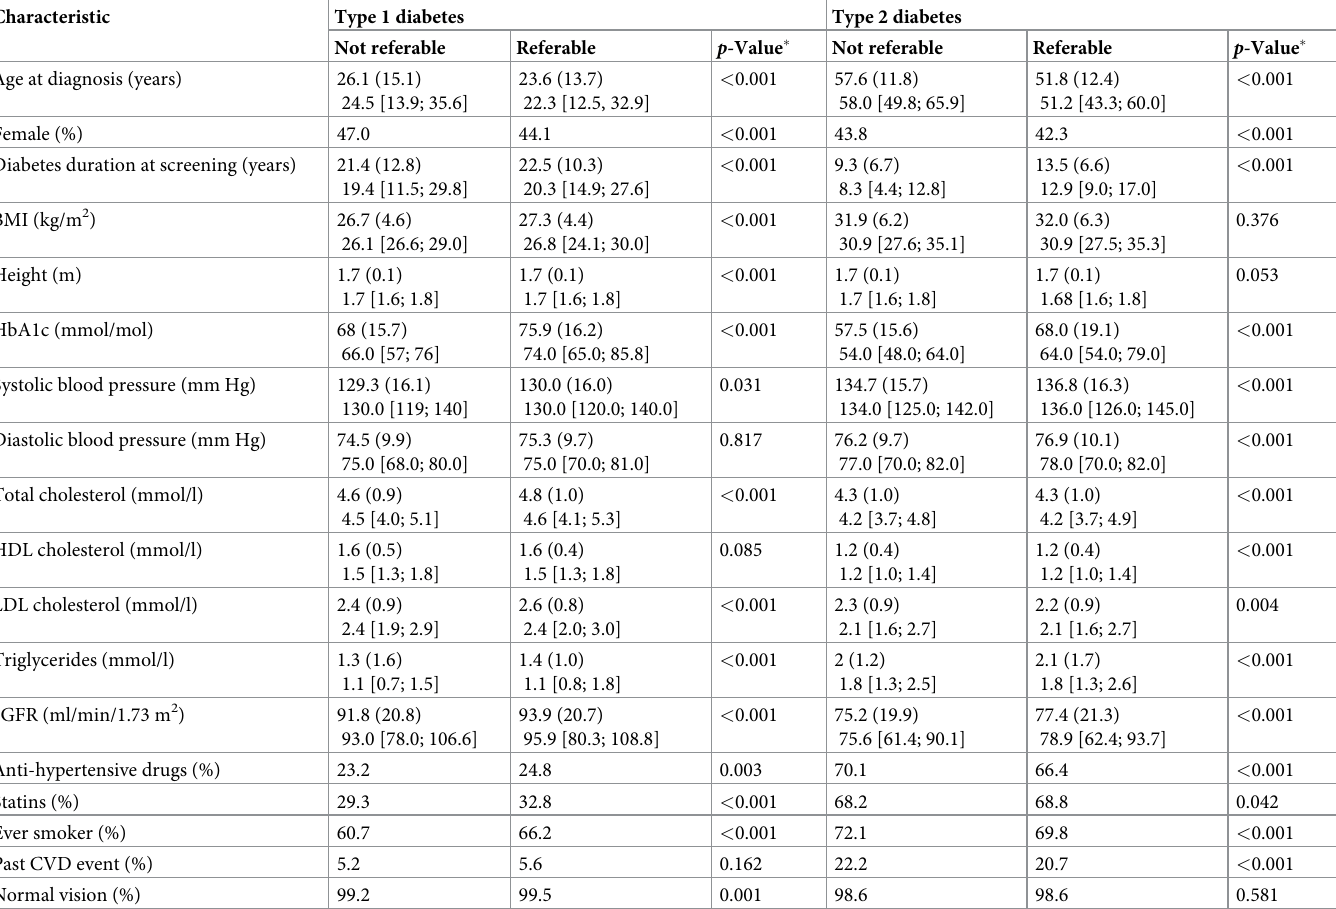
Table 1. Clinical measures at baseline in patients with type 1 and type 2 diabetes who did versus did not develop referable diabetic retinopathy over the study